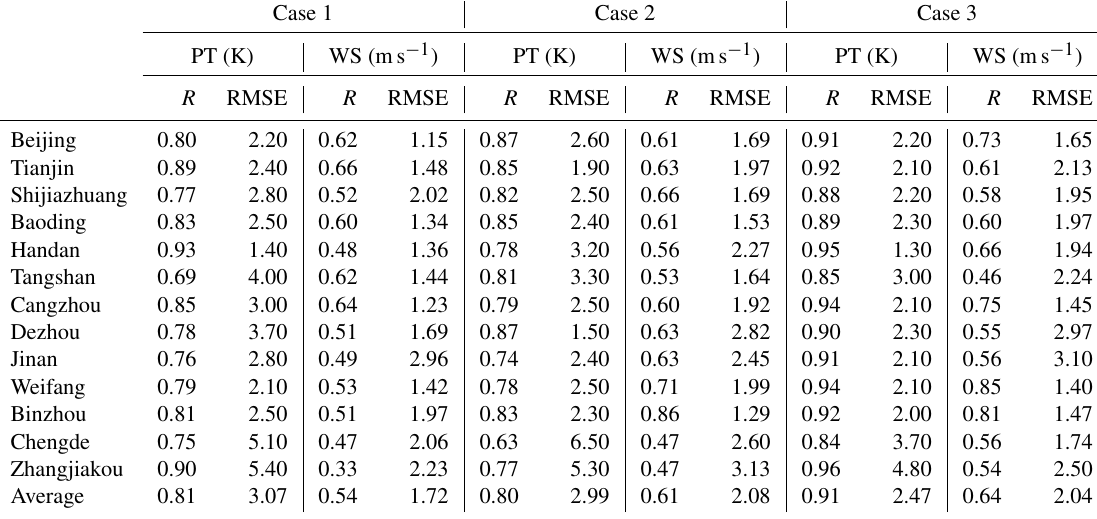
Table 1. Statistics of model performance for the hourly evolution of near-surface potential temperature and 10m wind speed for the selected 13 cities during the representative